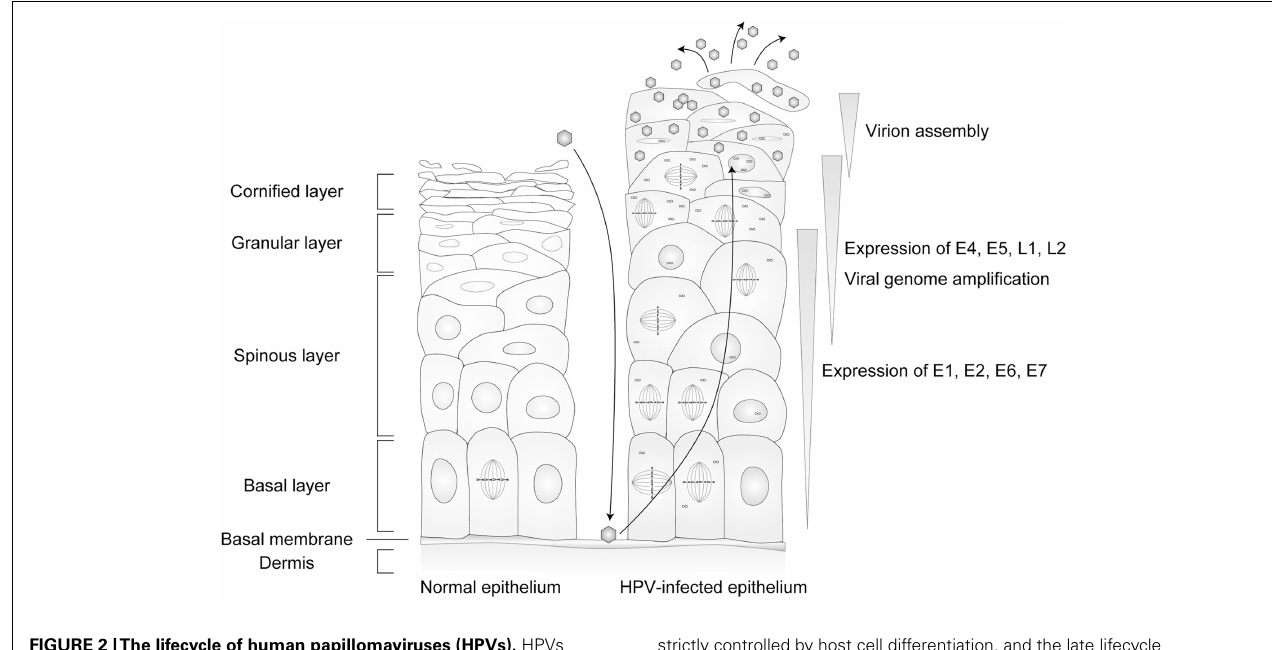
FIGURE 2 |The lifecycle of human papillomaviruses (HPVs). HPVs infect specifically the cells in the basal layer of the stratified epithelium through lesions.Viral genomes are maintained as episomal DNA in the nuclei of infected cells.The viral lifecycle is